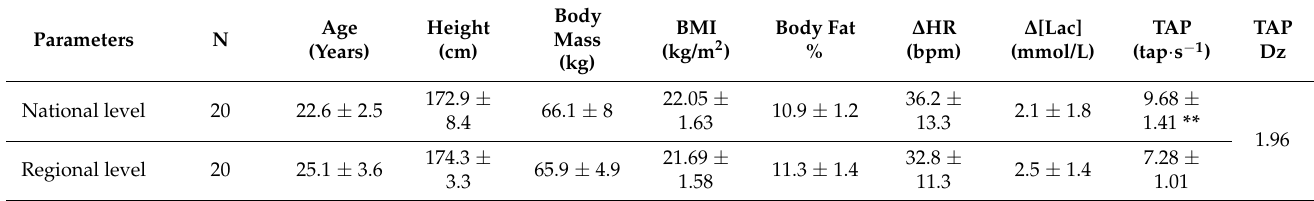
Table 1. Anthropometric and physiological parameters in soccer player groups.